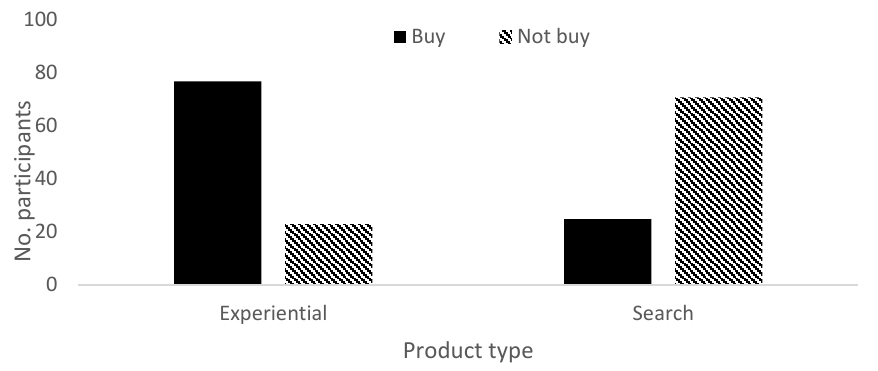
Figure 4. Consumer purchase behavior according to product type.